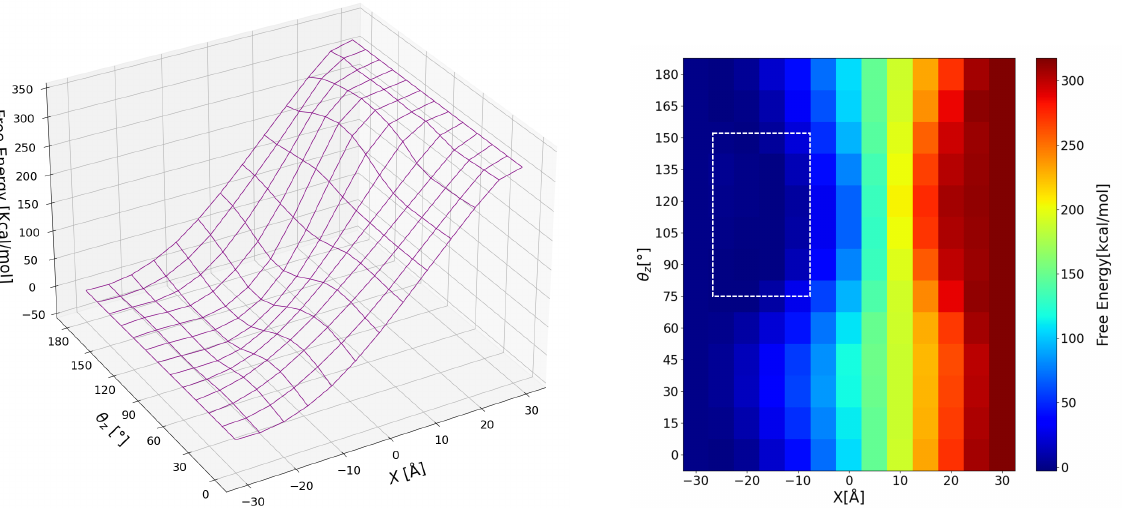
Figure 5. Adsorption free energy; ( Left ) free energy surface, ( Right ) contour color map. The area indicated with dashed lines in the color map is the parameter range for investigation with the finer grid.